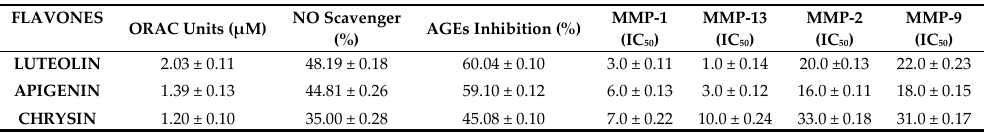
Table 1. Antioxidant and anti-glycation activity of flavones. Data were expressed as mean ± SD of three determinations.